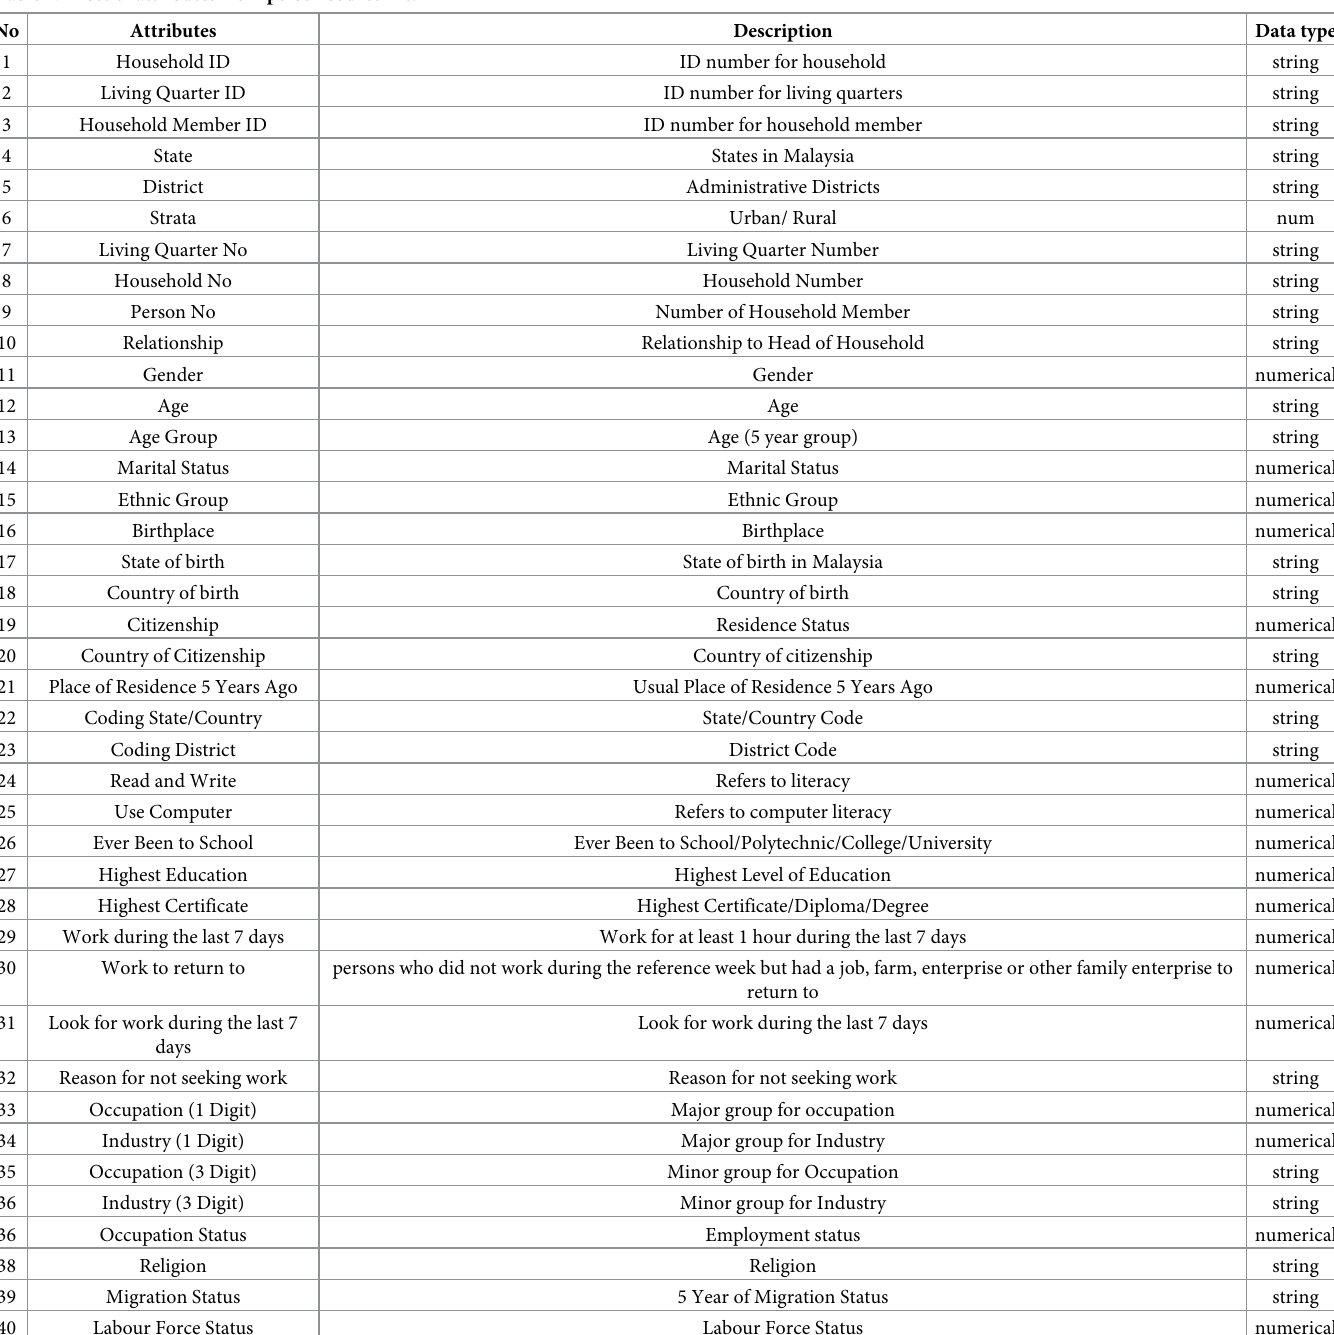
Table 2. A set of attributes from person source